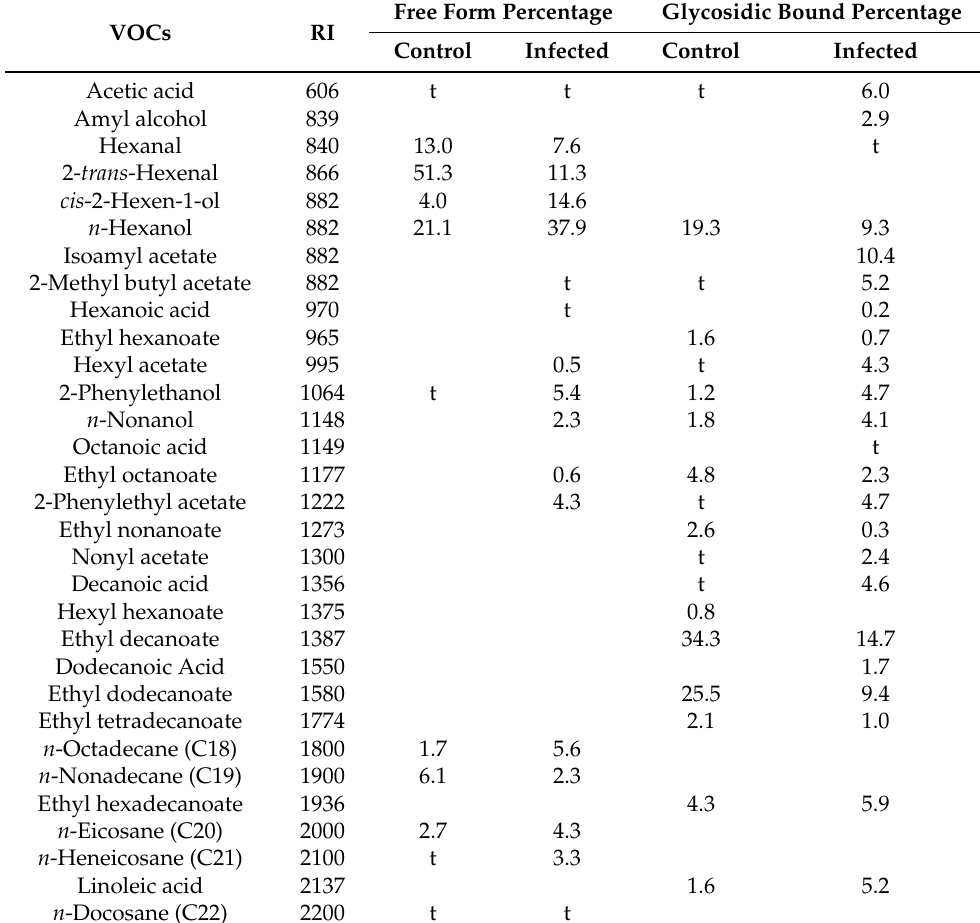
Table 1. Free and glycosidic bound volatile organic compounds expressed as a percentage of total VOC content, in both control and B. cinerea infected Trincadeira grapes. Compounds with relatively high percentages (ethanol, isopropyl alcohol, acetaldehyde, ethyl acetate, and isoamyl alcohol) were removed as described in the Materials and Methods section (full list of compounds available in Table S1). Free and glycosidic form VOCs were analysed in separate runs. Free Form Percentage Glycosidic Bound Percentage VOCs RI Control